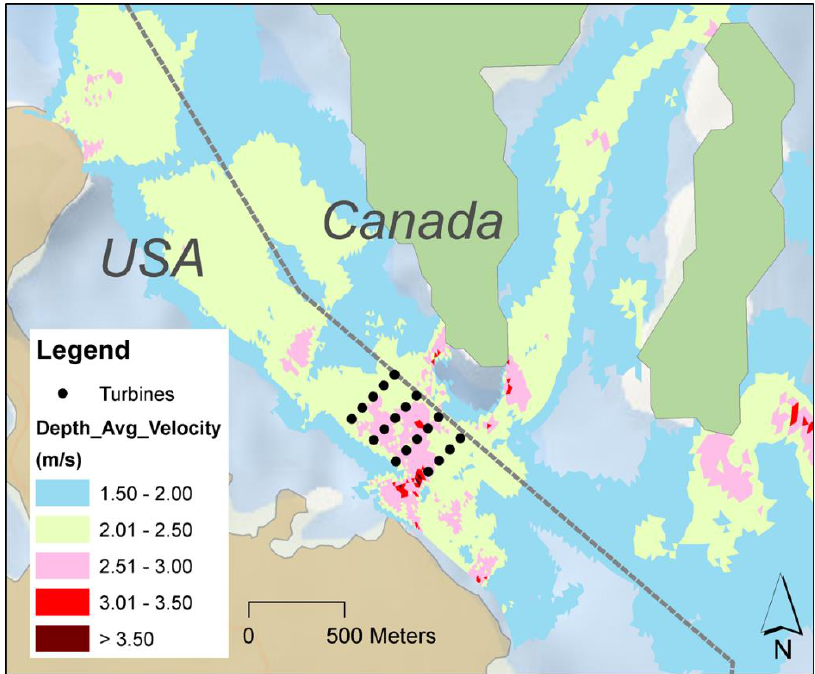
Figure 14. Layout of the hypothetical tidal turbine farm in the Western Passage. Table 6. Tidal turbine configuration and simulated extractable power in the Western Passage.